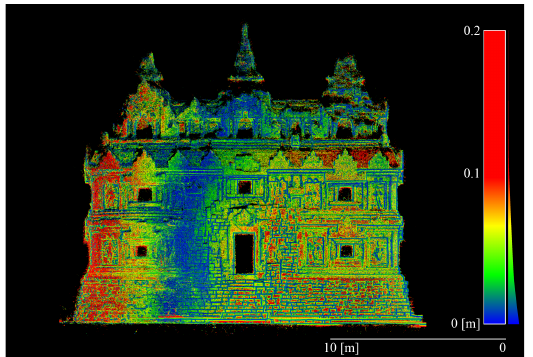
Figure 8. False-color representation of point distances between the laser scanning point cloud and the handheld image